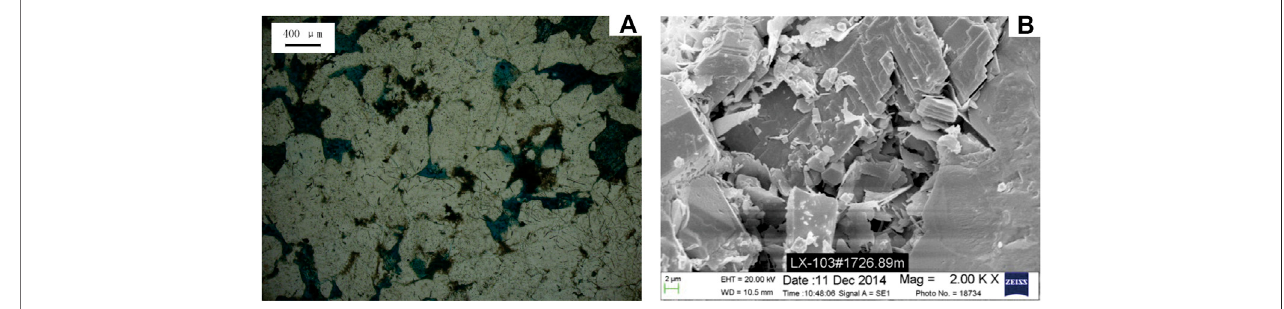
FIGURE1| Thedevelopment and structure ofpores ofdensesandstone: (A) thedevelopmentofpores basedonmicroelectron microscopy,and (B) thestructure of pores based on fi eld emission scanning electron microscopy.